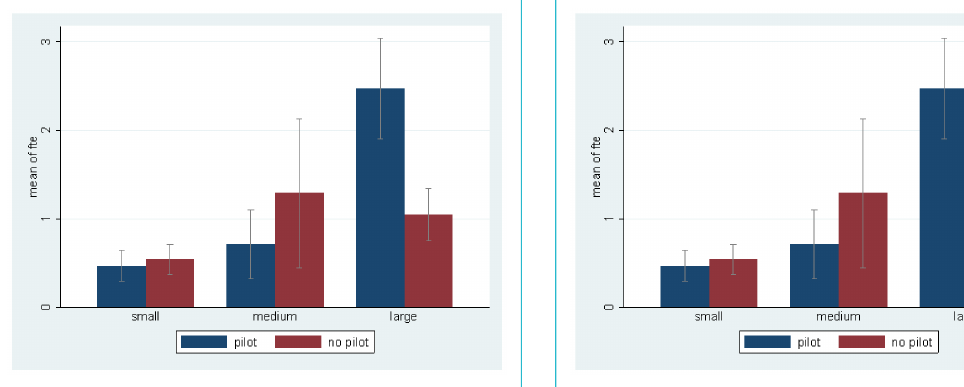
Figure 1: Fulltime equivalents (FTEs) dedicated to healthcare-as- sociated infection surveillance by hospital size, stratified by elec-